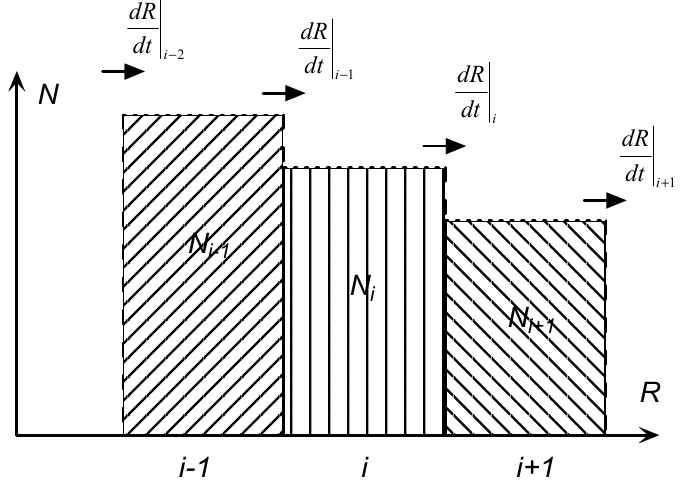
Figure 6. Discretized size distribution of precipitates.